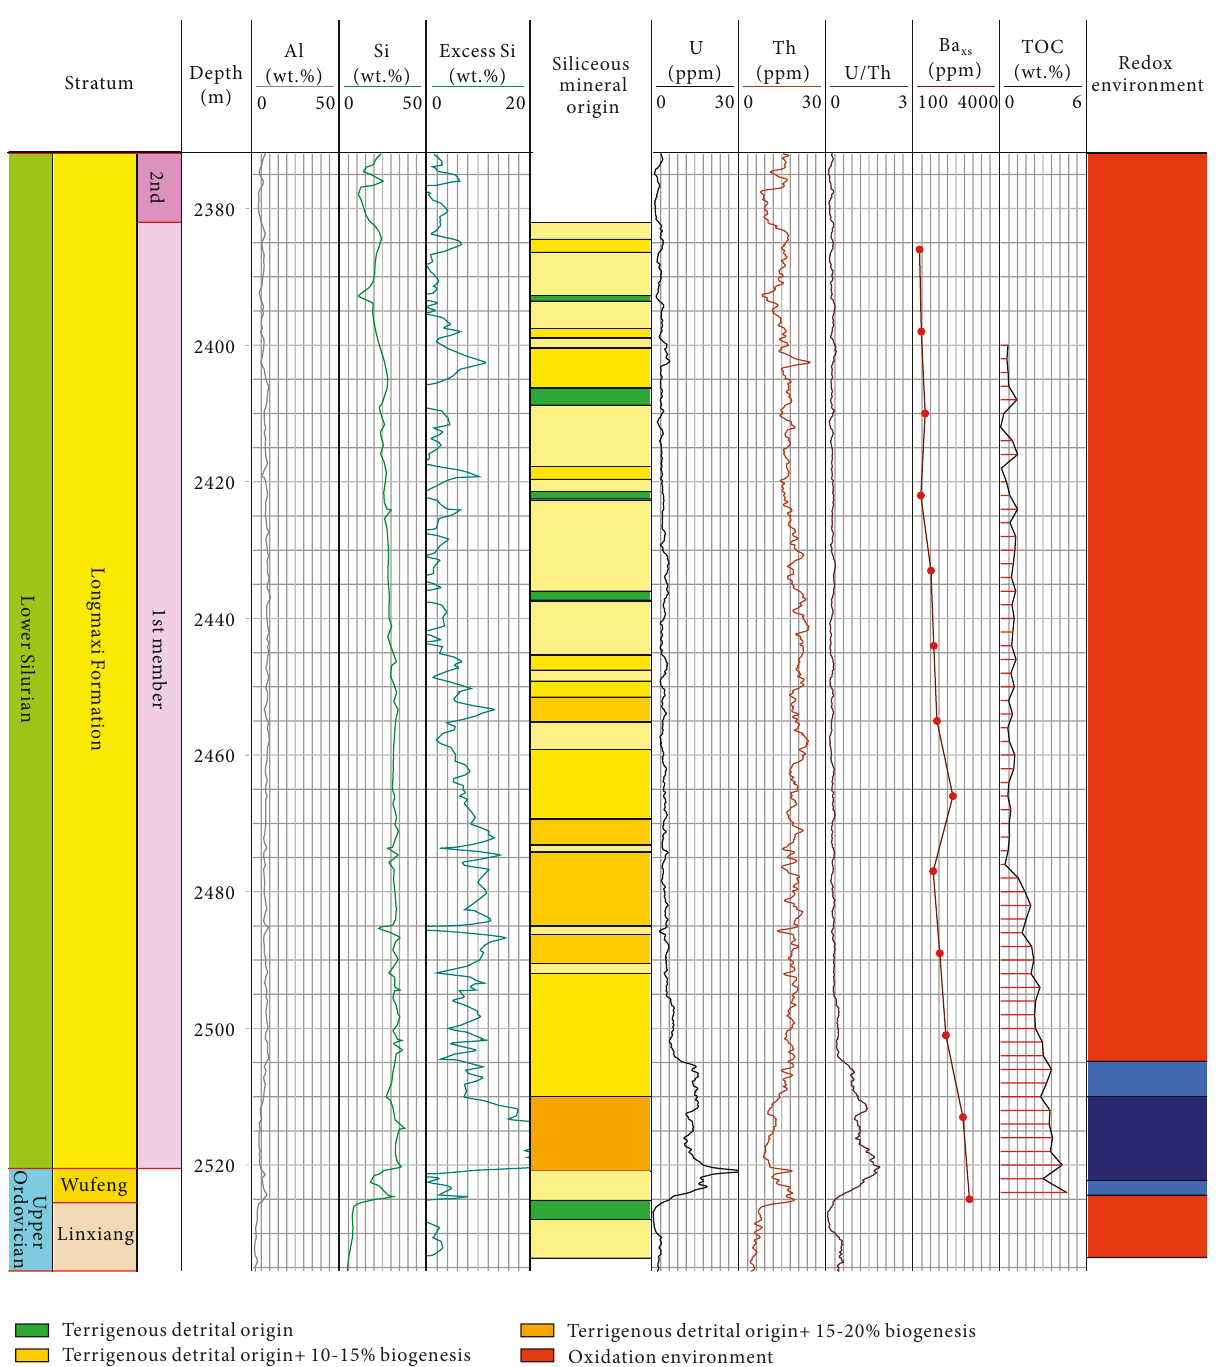
Figure 4: Excess silicon content, redox environment characteristics, paleoproductivity ( Ba Wufeng Formation-lower Silurian no. 1 member of the Longmaxi Formation from the X-1 well in the upper Yangtze region. See Figure 1 for the well